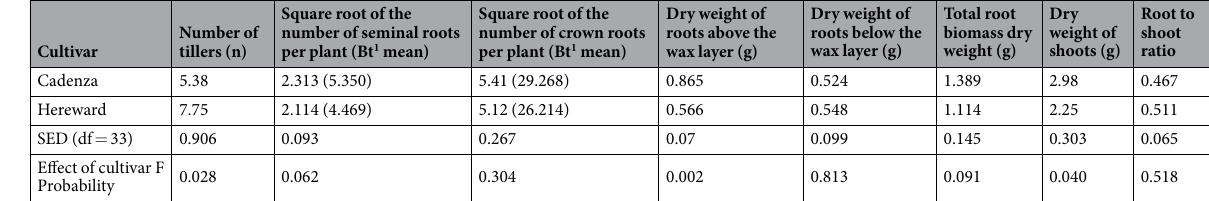
Table 5. Controlled environment wax layer root penetration experiment, measures of root architecture at tillering. Average tiller number, number of roots (crown and seminal), dry weight of roots (total, above and below the wax layer), dry weight of shoots and root to shoot ratio. Data averaged across strong and weak wax layer strengths as there was no significant main effect of wax strength or interaction between wax strength and cultivar. 1 Bt =